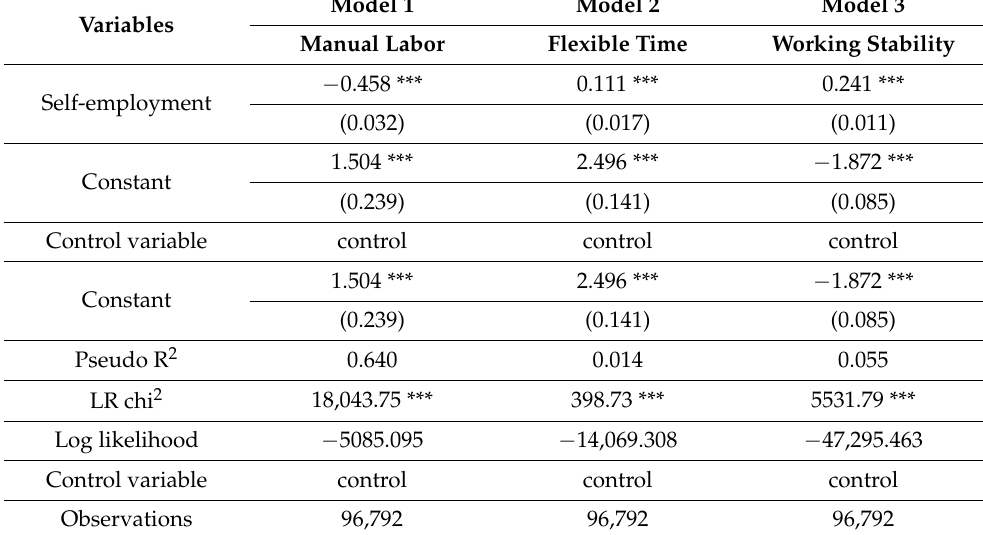
Table 8. The results of direct mechanism.